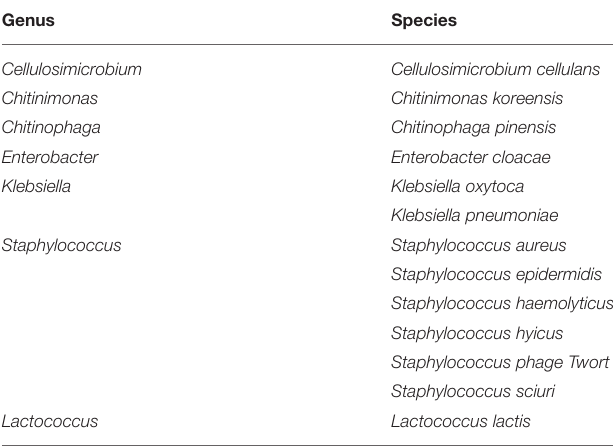
TABLE 4 | Microbe species related to cellulose digestion or chitin